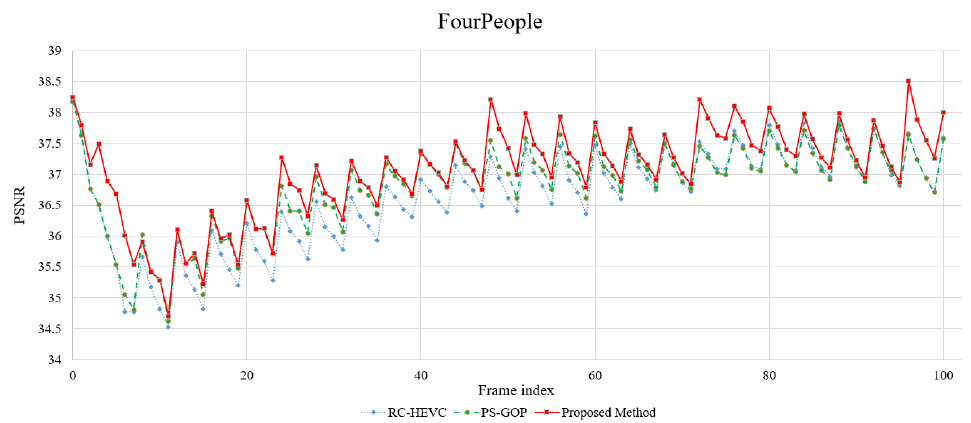
Figure 5. Comparison of PSNR difference between consecutive frames.